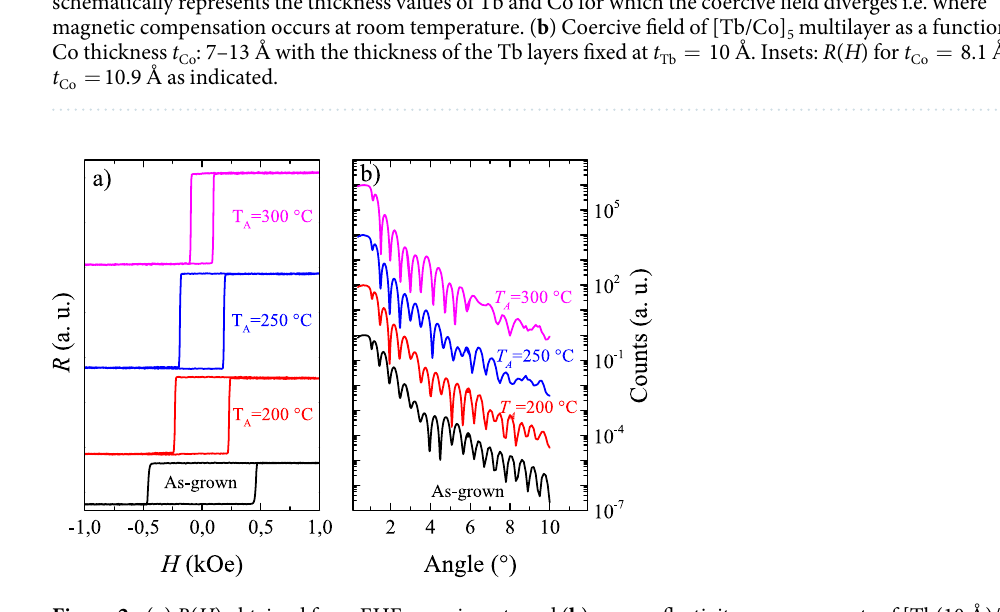
Figure 2. ( a ) R ( H ) obtained from EHE experiments and ( b ) x-ray reflectivity measurements of [Tb(10 Å )/ Co(12 Å )] 5 samples as-deposited and annealed at temperatures T A = 200, 250 and 300 ° C as